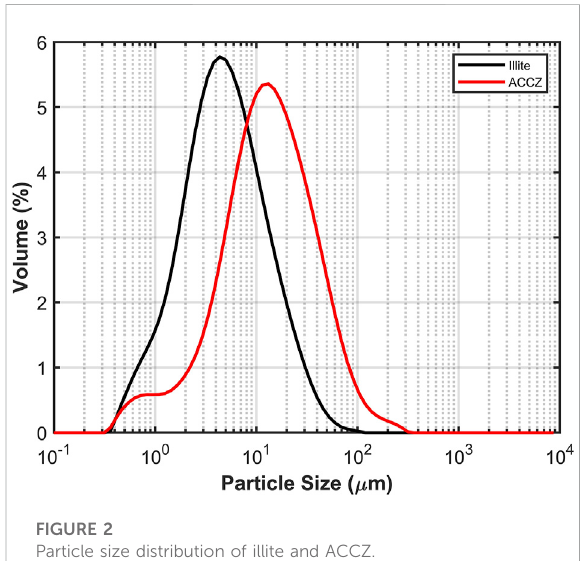
FIGURE 2 Particle size distribution of illite and